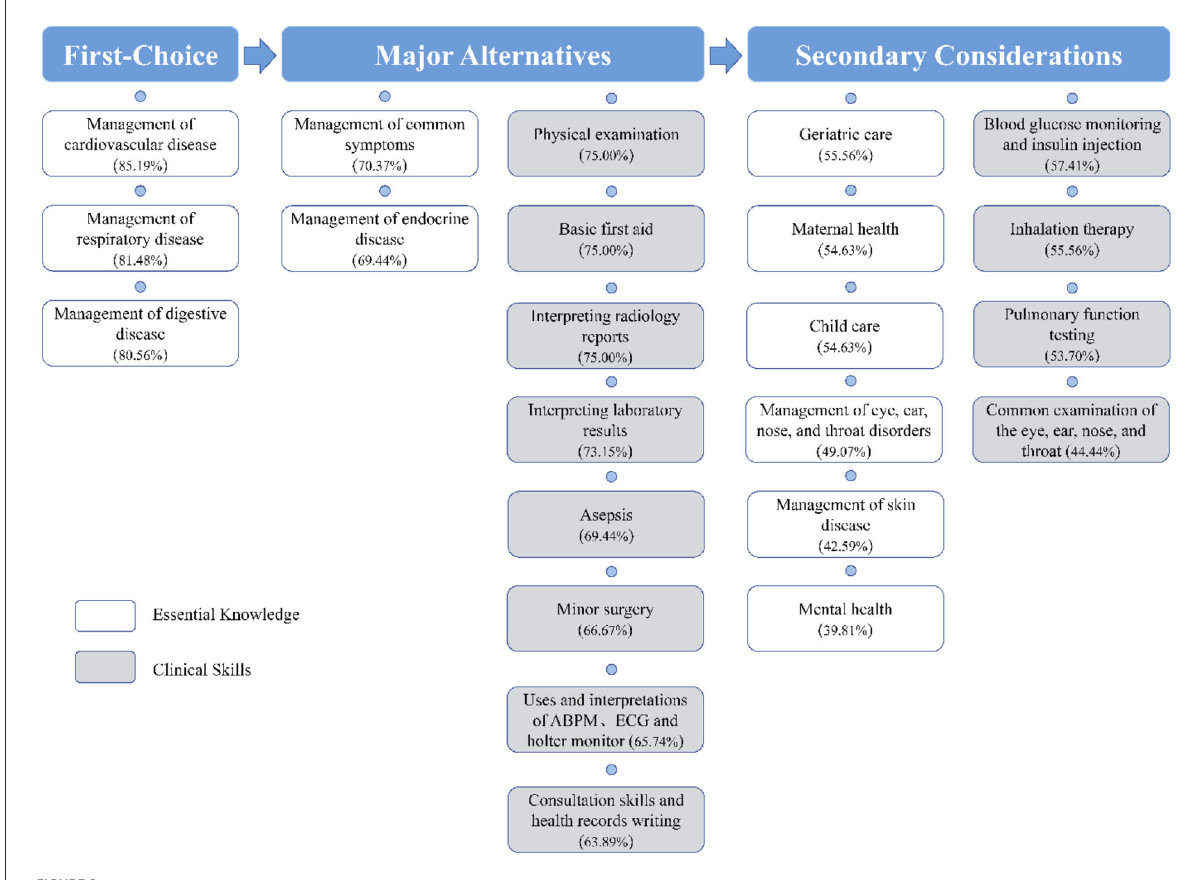
FIGURE2 Flowchart depicting the priority